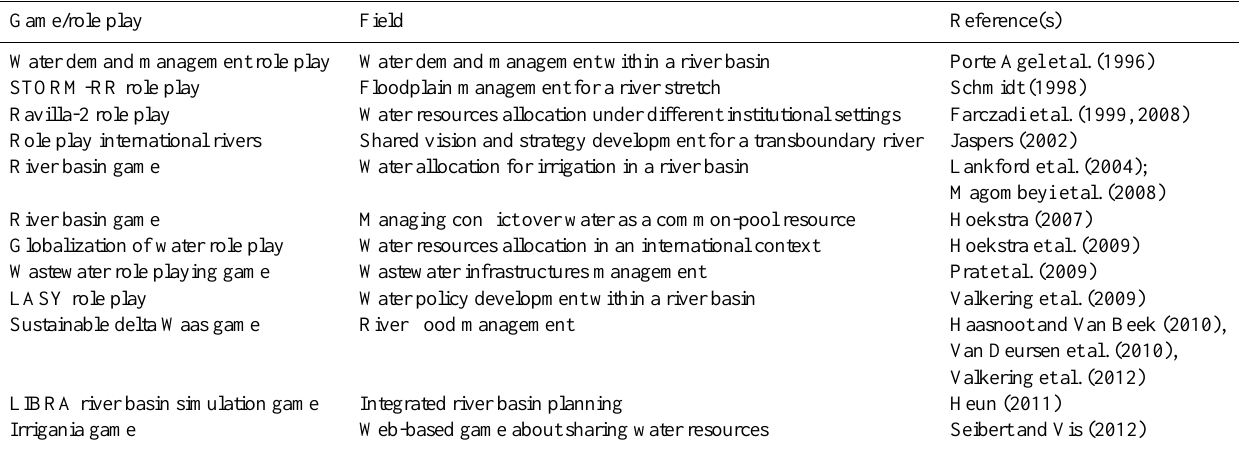
Table 1. Simulation games and role plays in hydrology and water